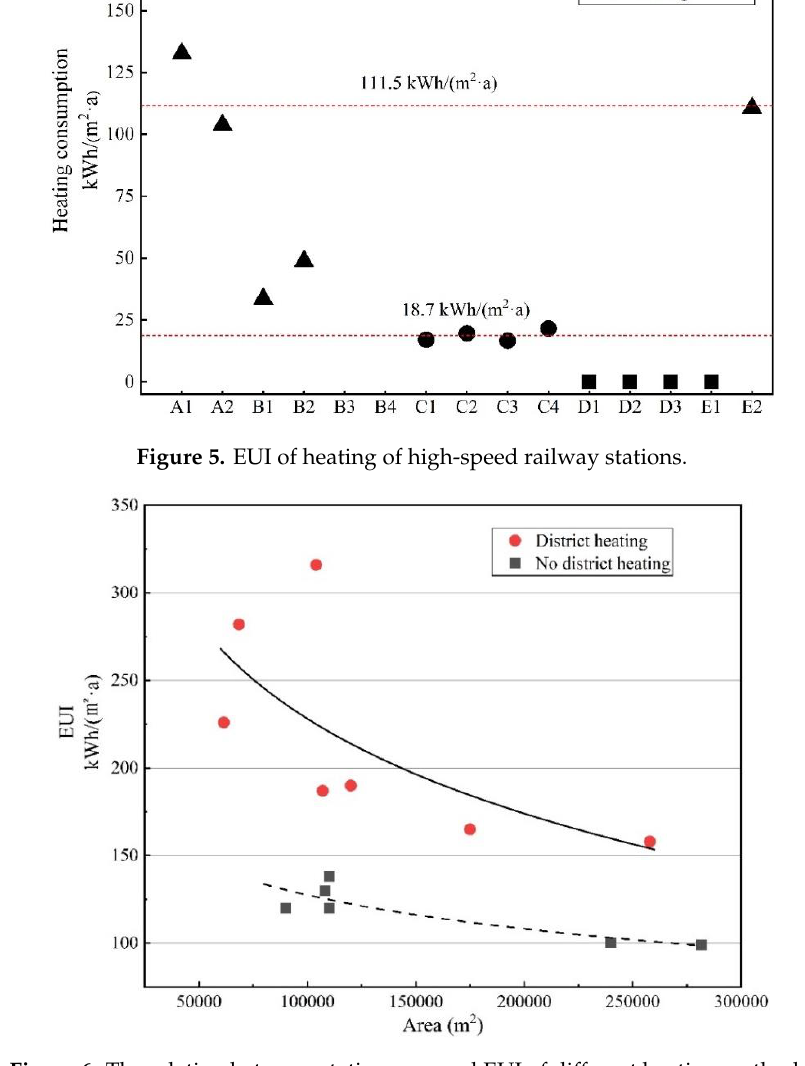
Figure 6. The relation between station area and EUI of different heating methods.